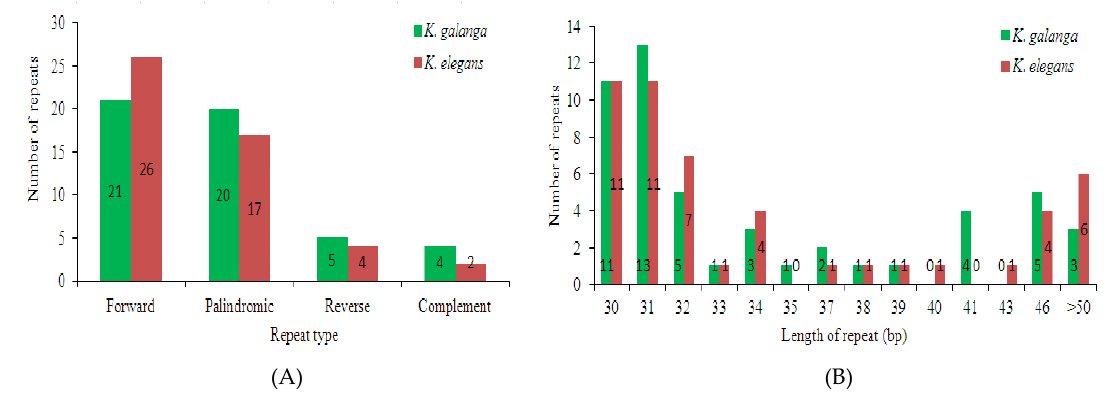
Figure 4. Analysis of long repeat sequences in the chloroplast genomes of K. galanga and K. elegans . ( A ) Frequency of long repeats types; ( B ) Frequency of long repeats by length.